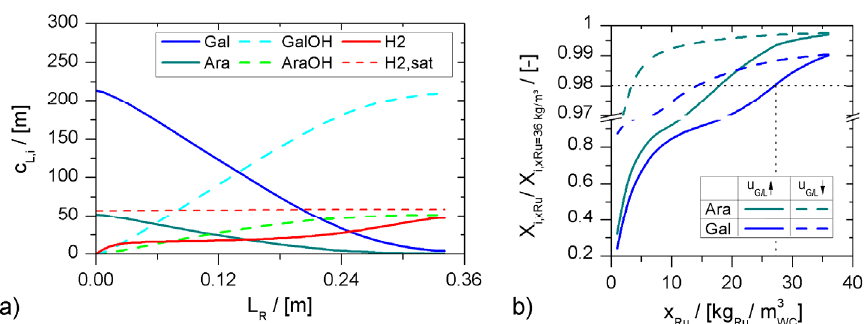
Figure 17. ( a ) Axial concentration profiles of all components in the liquid phase within the mini trickle-bed reactor at 𝑢 (cid:3013),(cid:3046) = 0.03 m/s , 𝑢 (cid:3008),(cid:3046) = 0.30 m/s , 𝑥 (cid:3019)(cid:3048) = 27.5 kg (cid:2902)(cid:2931) /m (cid:2907)(cid:2887)(cid:2871) and ( b ) effect of re- duced ruthenium content on the conversion of both reactants for high throughput (𝑢 (cid:3008)/(cid:3013) ↑ : 𝑢 (cid:3013),(cid:3046) = 0.03 m/s , 𝑢 (cid:3008),(cid:3046) = 0.30 m/s , 𝐿 (cid:3019) = 0.34 m ) and low throughput (𝑢 (cid:3008)/(cid:3013) ↓ : 𝑢 (cid:3013),(cid:3046) = 0.001 m/s , 𝑢 (cid:3008),(cid:3046) = 0.01 m/s , 𝐿 (cid:3019) = 0.53 m ).